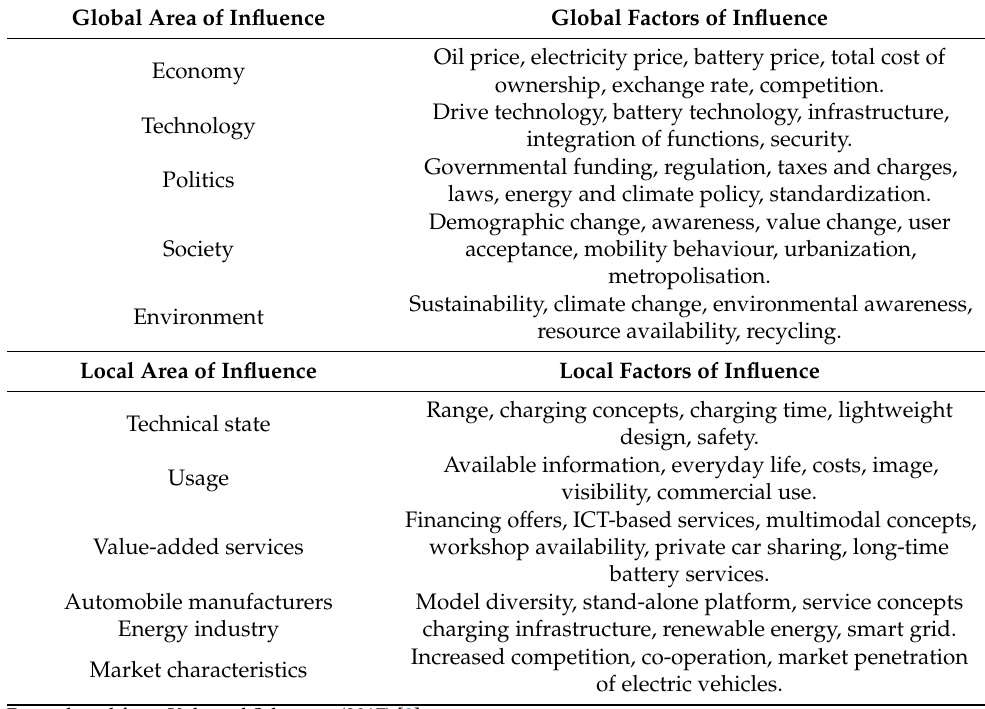
Table 3. Electromobility influence factors.